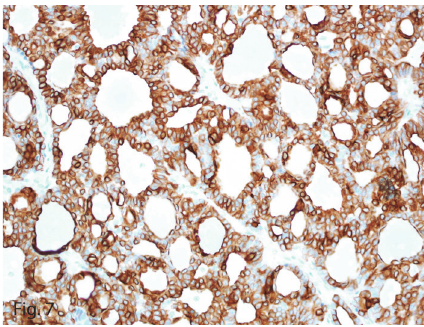
Figure 5: Recurrent hepatic neuroendocrine tumor in 2007 with low-grade morphologic characteristics and a low mitotic count (hematoxylin-eosin, original magnification × 40).